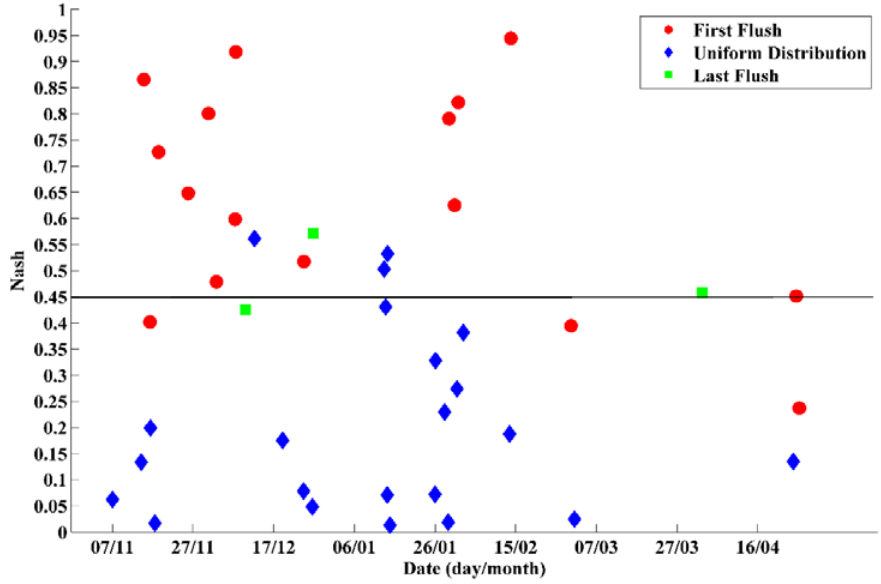
Figure 5. Variation of the Nash–Sutcliffe coefficients obtained when calibrating on first flush, uniformly distributed and last flush events.